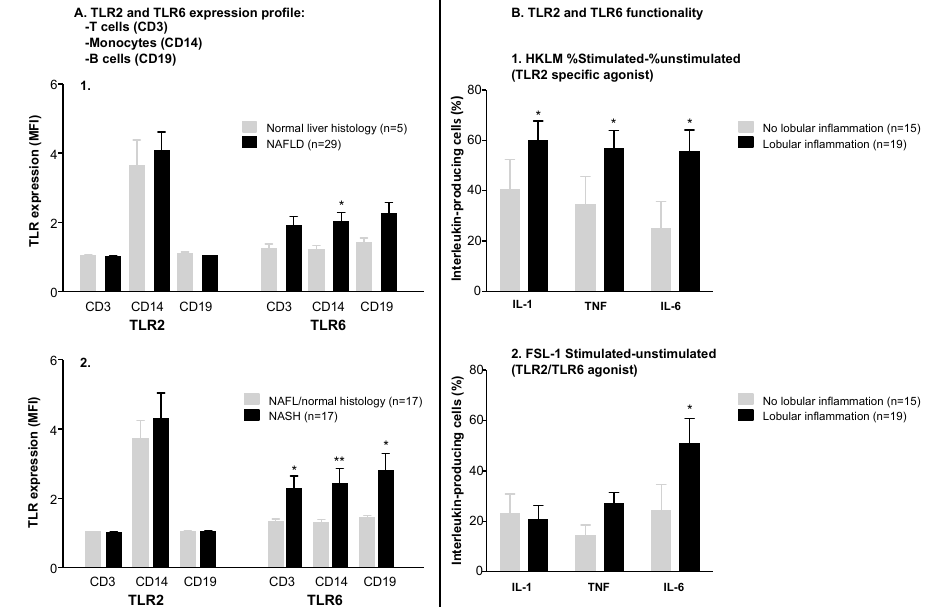
Figure 1. ( A1 ) Toll-like receptor 6 (TLR6) expression profile is different in monocytes of non-alcoholic fatty liver disease (NAFLD) patients compared to morbidly obese (MO) patients with a normal liver histology. TLR expression profile in peripheral blood mononuclear cells (PBMCs) of MO patients with and without NAFLD (mean (95% CI)). (TLR6: 1.95 mean fluorescence intensity (MFI) (1.27–2.64) in NAFLD compared to 1.20 MFI (0.84–1.56) in MO with normal histology; p < 0.05); ( A2 ) TLR6 expression is increased in PBMCs (T cells, monocytes and B cells) of MO patients with a possible or definite diagnosis of non-alcoholic steatohepatitis (NASH) (according to NAFLD activity index). TLR expression profile in PBMCs of MO patients with and without NASH. (TLR6 in T cells: 2.29 MFI (1.44–3.15) in NASH compared to 1.31 MFI (1.68–1.46) in non-NASH; p = 0.05. TLR6 in monocytes: 2.45 MFI (1.45–3.45) in NASH compared to 1.28 MFI (1.12–1.45) in non-NASH; p = 0.004. TLR6 in B cells: 2.79 MFI (1.75–3.82) in NASH compared to 1.41 MFI (1.26–1.57) in non-NASH; p = 0.02). MFI: mean fluorescence intensity; ( B ) intracellular production of pro-inflammatory cytokines is significantly increased in monocytes of morbidly obese patients with lobular inflammation. Patients with lobular inflammation displayed an increased production of IL6 in response to specific stimulation with TLR2 (HKLM) ( p = 0.01) ( B1 ) and TLR6 (FSL-1) ( p = 0.02) agonists ( B2 ). TNF α and IL-1 β were also increased in response to stimulation with HKLM ( p = 0.03 and p = 0.01, respectively) ( B1 ). * p < 0.05. ** p <